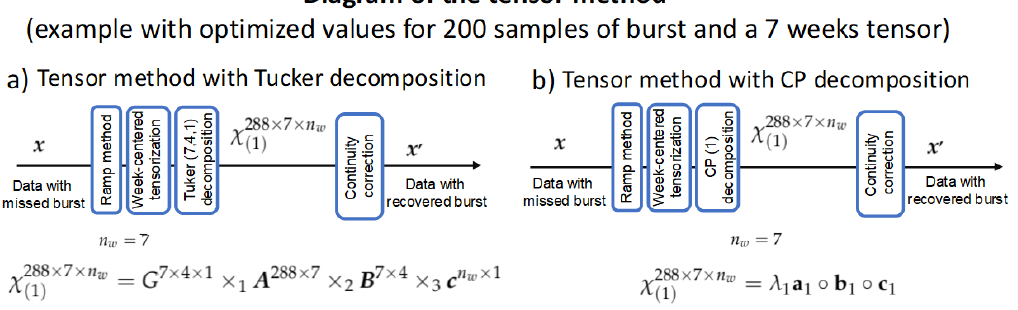
Figure 1. Graphic representation of the tensor method operations with the optimised configuration for our database in order to recover a burst of 200 lost samples when employing a tensor size of 288 × 7 × 7. ( a ) The Tucker model. ( b ) The CANonical DECOMPosition/PARAllel FACtorization (CANDECOMP/PARAFAC or CP)